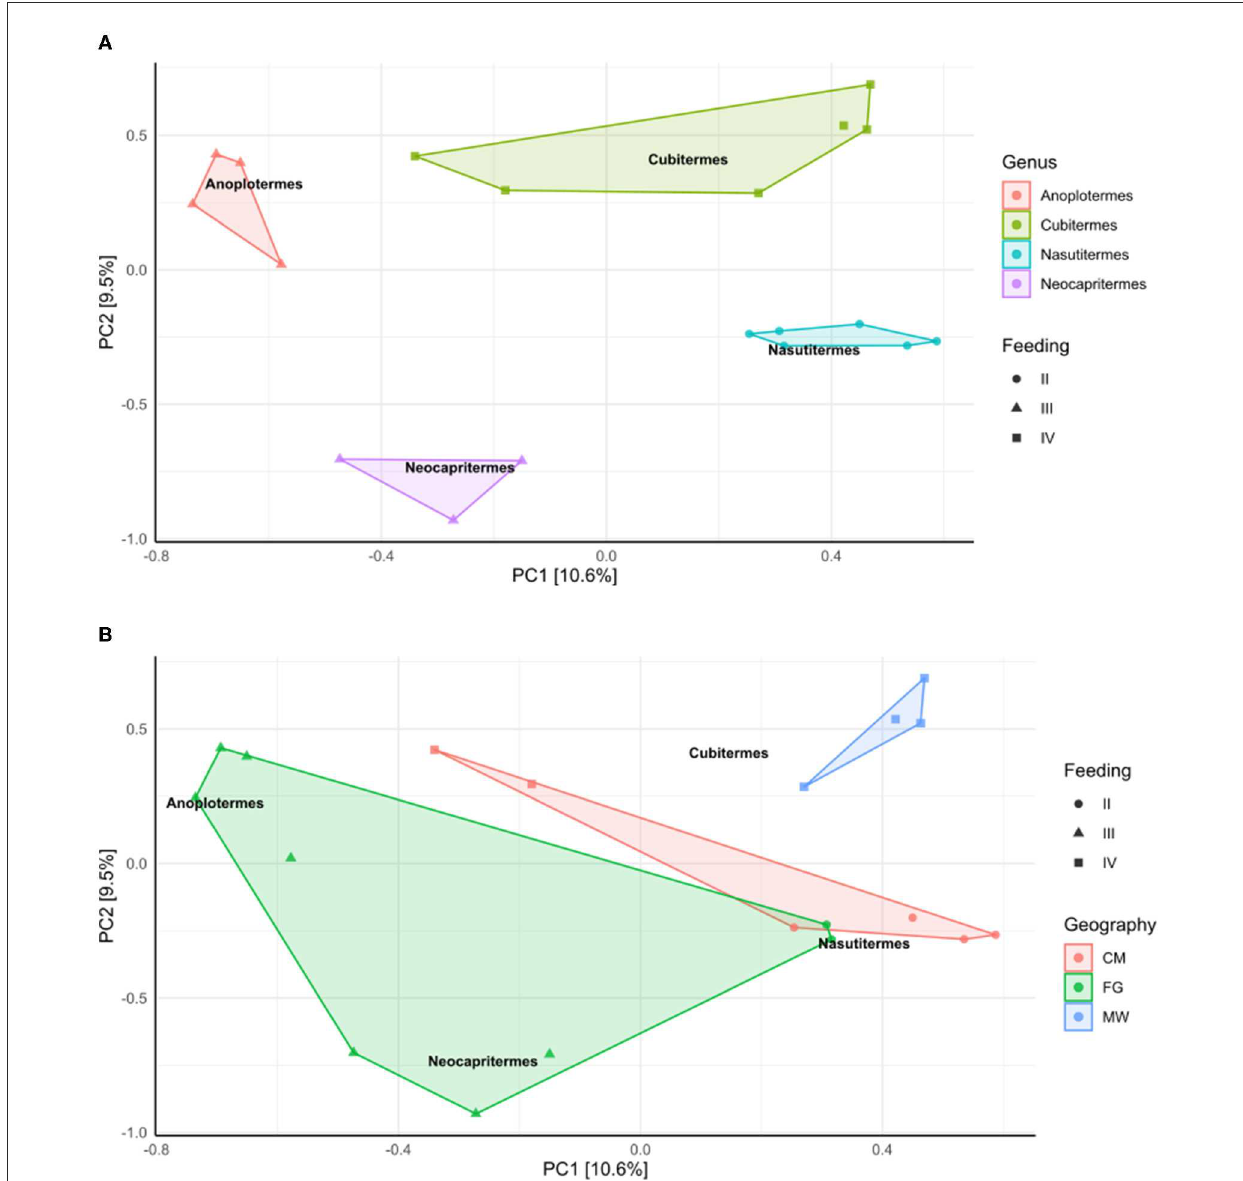
FIGURE5 PCA analysis with ITS data after elimination of samples with < 3 representatives per genus, and the tags from the negative sample control. (A) Samples were subjected to Hellinger transformation, sample constraint, and color were “Genus,” and shape by feeding strategy. (B) Samples were subjected to Hellinger transformation, sample constraint was “Genus,” while sample color was geography, and shape by feeding strategy. Genera indications are kept as shown in Figure